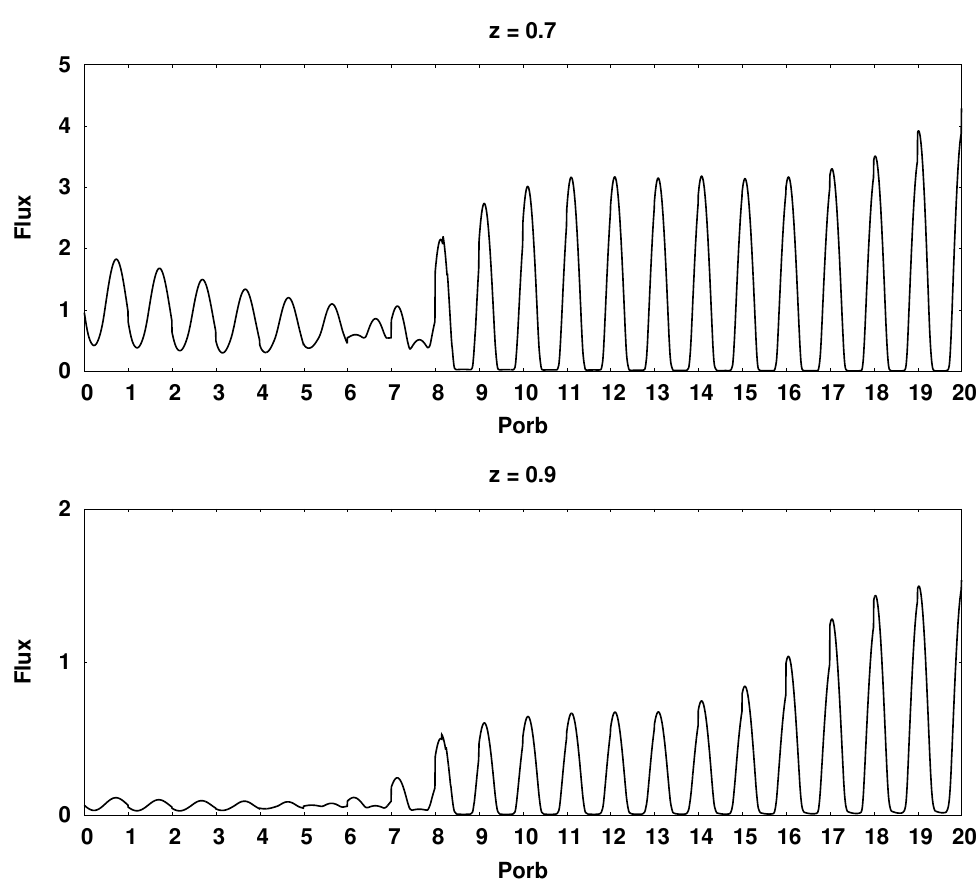
Figure 17. Synthetic bolometric light curves of the CD Ind polar for various values of the dipole displacement at the moment of switching the flow from the north magnetic pole to the south. The flux values are in units 10 33 erg/s. At the top of each panel, the value of the displacement of the dipole center is